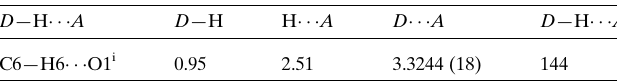
Table 1 Hydrogen-bond geometry (A˚ , (cid:3) ).